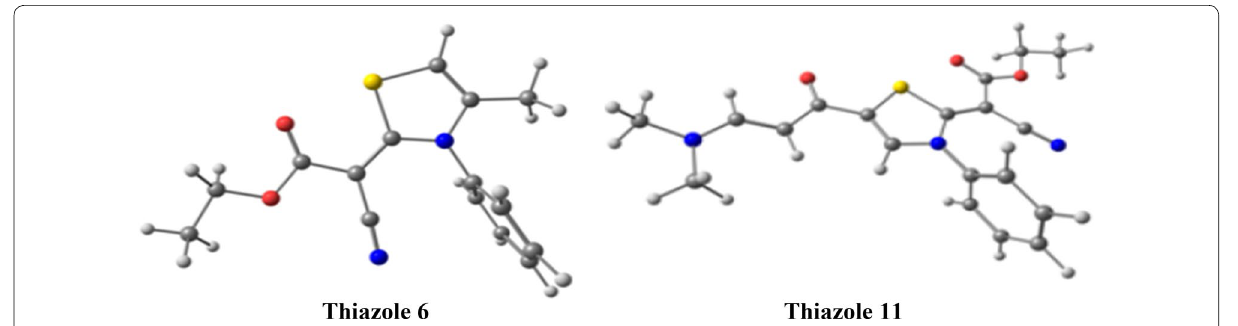
Fig. 5 The optimized structure of the thiazoles 6 and 11